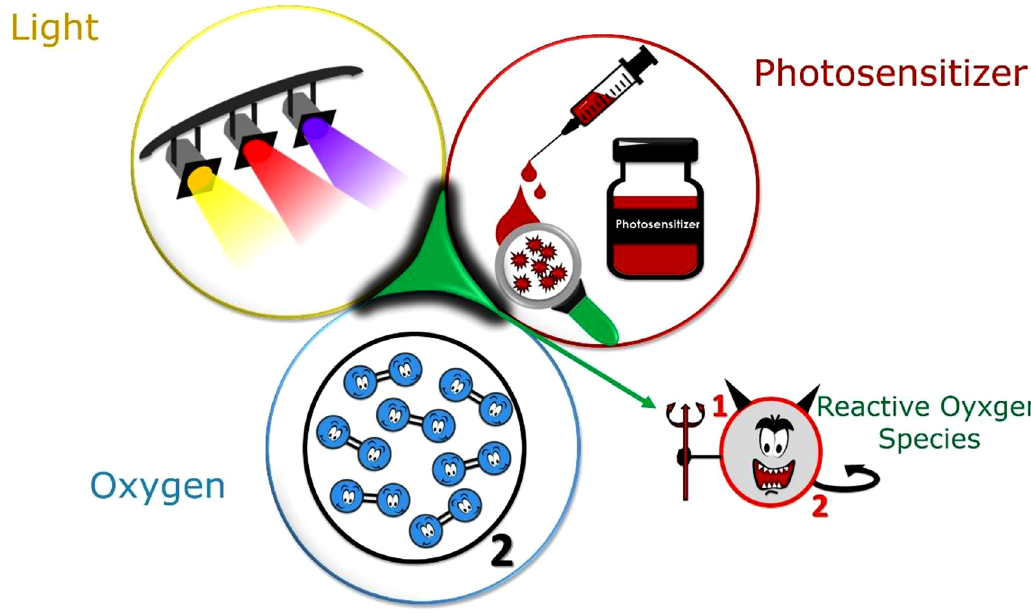
Figure 1: Schematic presentation of PDT